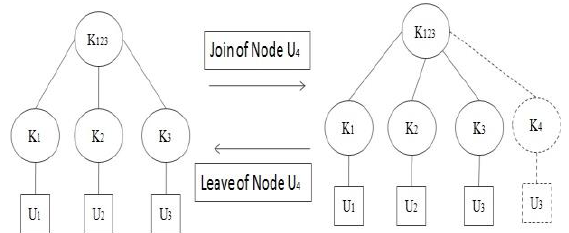
Figure 2: Hybrid group key management joining and leaving operations Figure 2: hybrid group key management Joining